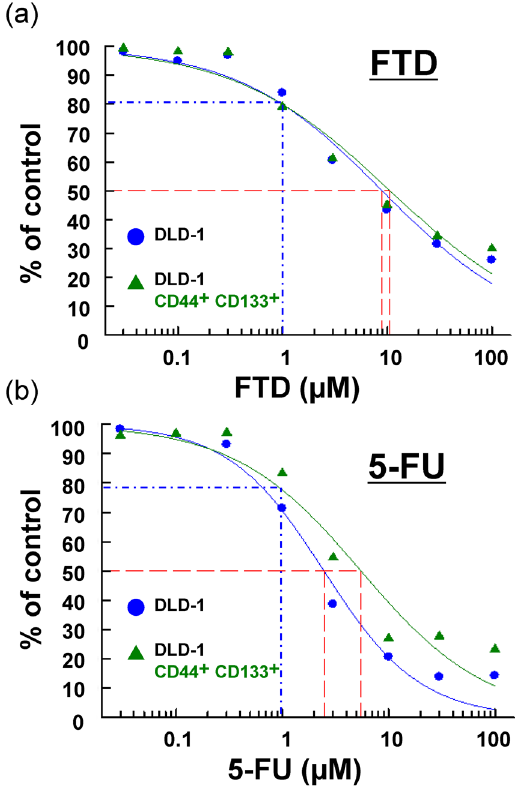
Figure 2. Antiproliferative effect of trifluridine (FTD) on isolated CD44 + CD133 + cells. Sorted CD44 + CD133 + cells (shown in Fig. 1) and unsorted DLD-1 cells shown here were cultured with various concentrations of FTD ( a ) and fluorouracil (5-FU) ( b ). Cell viability was determined using crystal violet staining based on at least three independent experiments. Data points represent means ± SD (n = 3). Blue dashed line represents estimated viability determined for 1 µ M FTD and 5-FU; values were estimated using a fitting curve in the logistic model. Red dashed line represents estimated IC 50